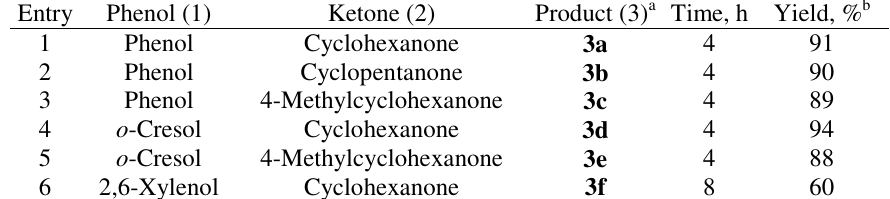
Table 1. Synthesis of bisphenols ( 3a-3f )